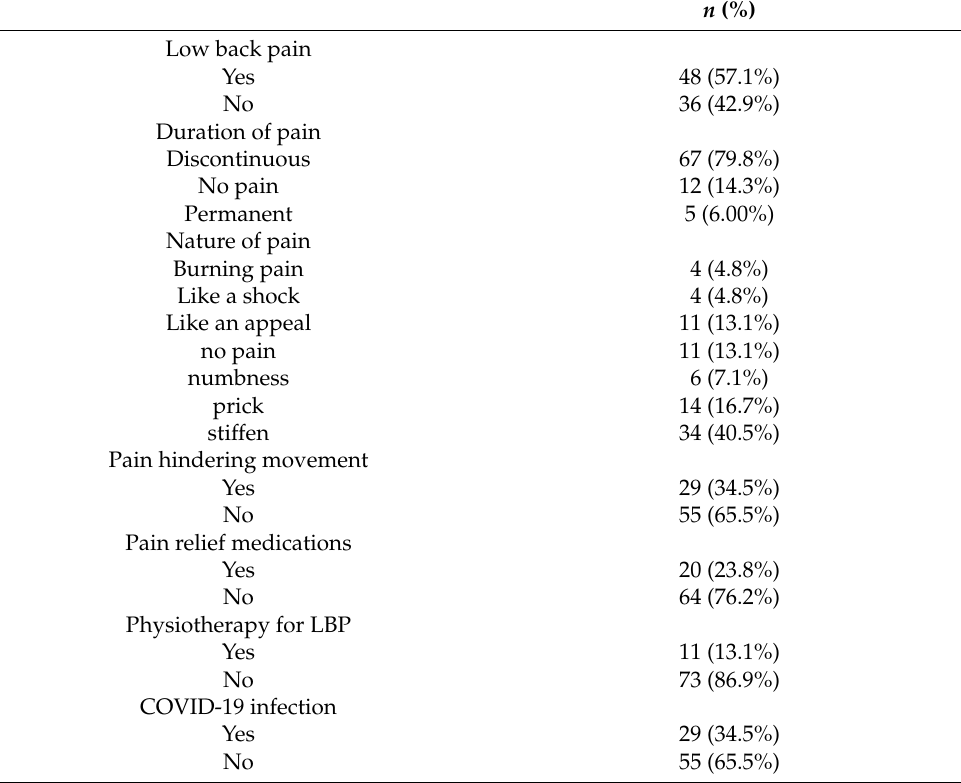
Table 3. Low back pain prevalence, duration, and nature, and associated